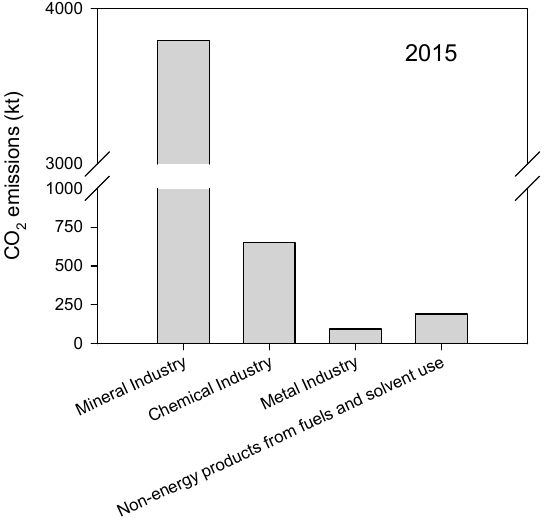
Figure 11. CO 2 emissions from industrial processes and product use (non-energy use) in 2015 (adapted from [40]).